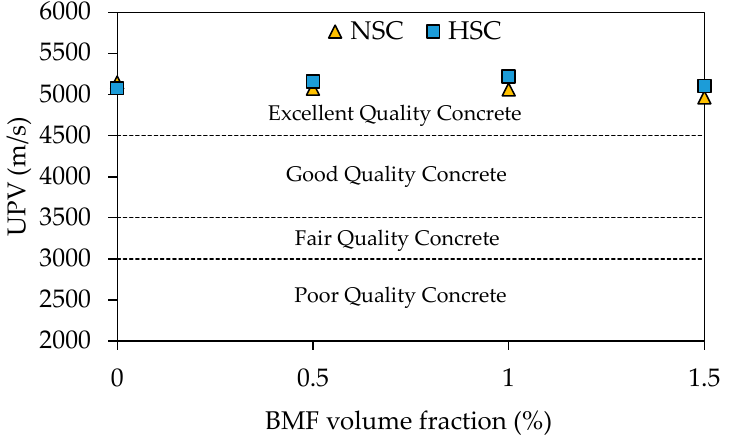
Figure 21. Ultrasonic pulse velocity versus BMF volume fraction relationship.